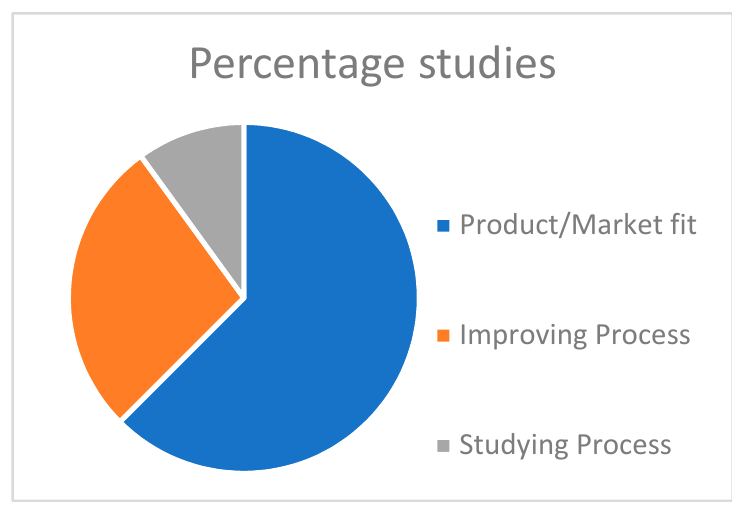
Figure 4. Percentage of studies with different underlying motivations.